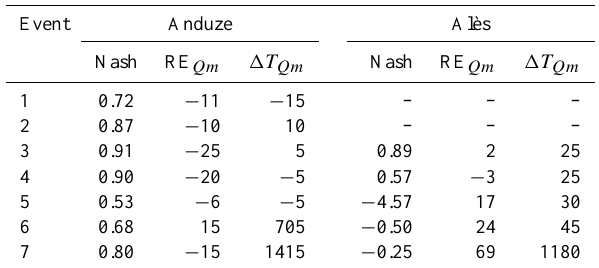
Table 4. Hydrologic modelling results. Performance indexes at the Anduze and Alès stations, in terms of Nash, RE Qm (characterising the error of the modelled peak, in %; see Eq. 11), and 1T Qm in- dexes (defining the delay or the early arrival of the modelled peak, in minutes; see Eq. 12). The values of the indexes were not cal- culated at Alès for event nos. 1 and 2, the rating curve not being defined when these episodes